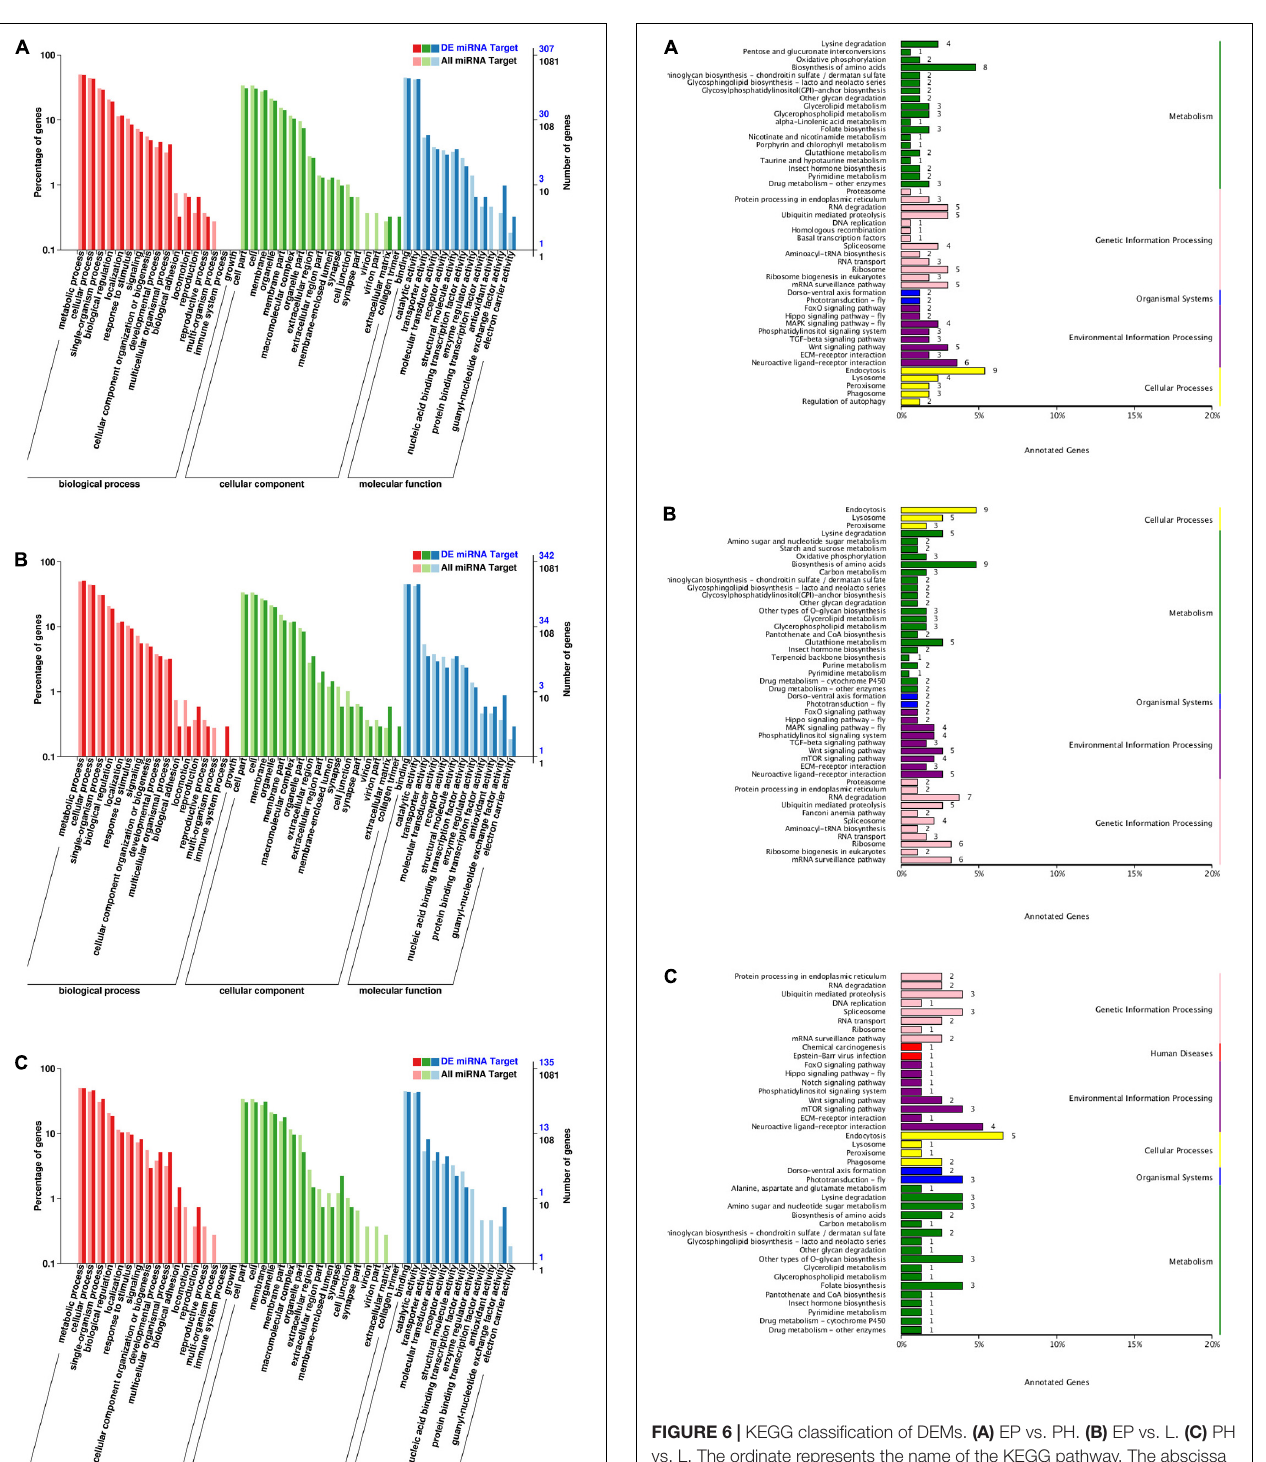
processes: 28 genes), CC (membrane: 43 genes, cell part: 42 genes, and cell: 35 genes), and MF (binding: 60 genes, and catalytic activity: 52